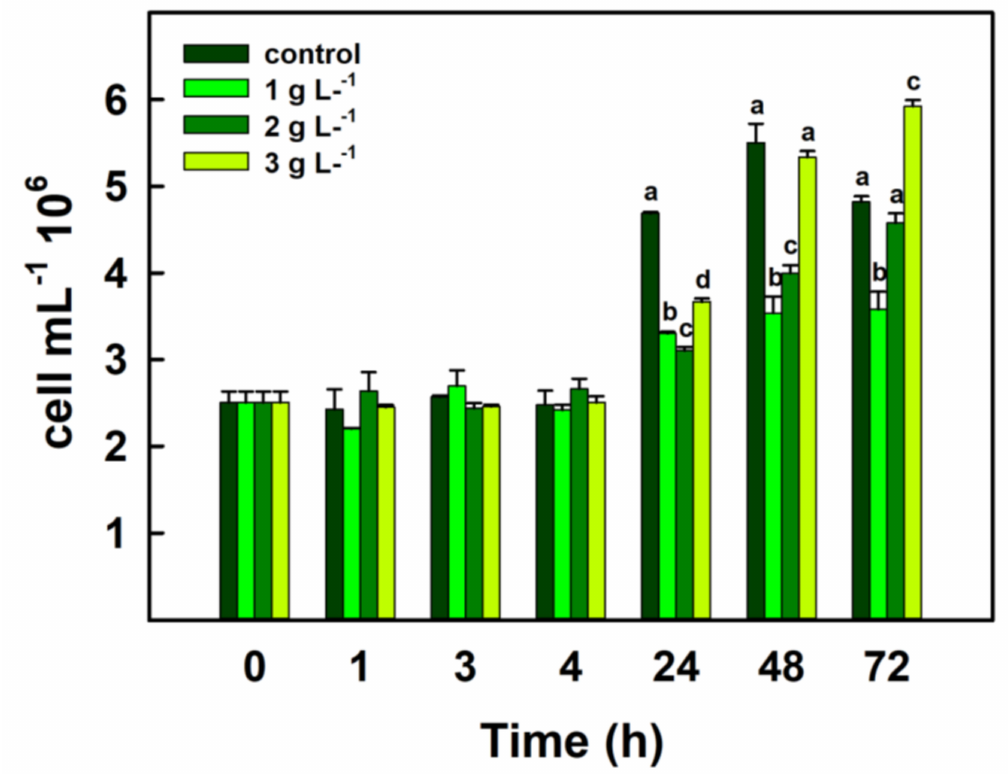
Figure 2. Cellular density (cells mL − 1 ) in Chlorella sorokiniana control and bicarbonate enriched cultures (NaHCO 3 1 g L − 1 , 2 g L − 1 , and 3 g L − 1 ). Error bars represent SD ( n = 3). The values with the same letter were not significantly di ff erent ( p ≤ 0.001, ANOVA, Tukey’s multiple